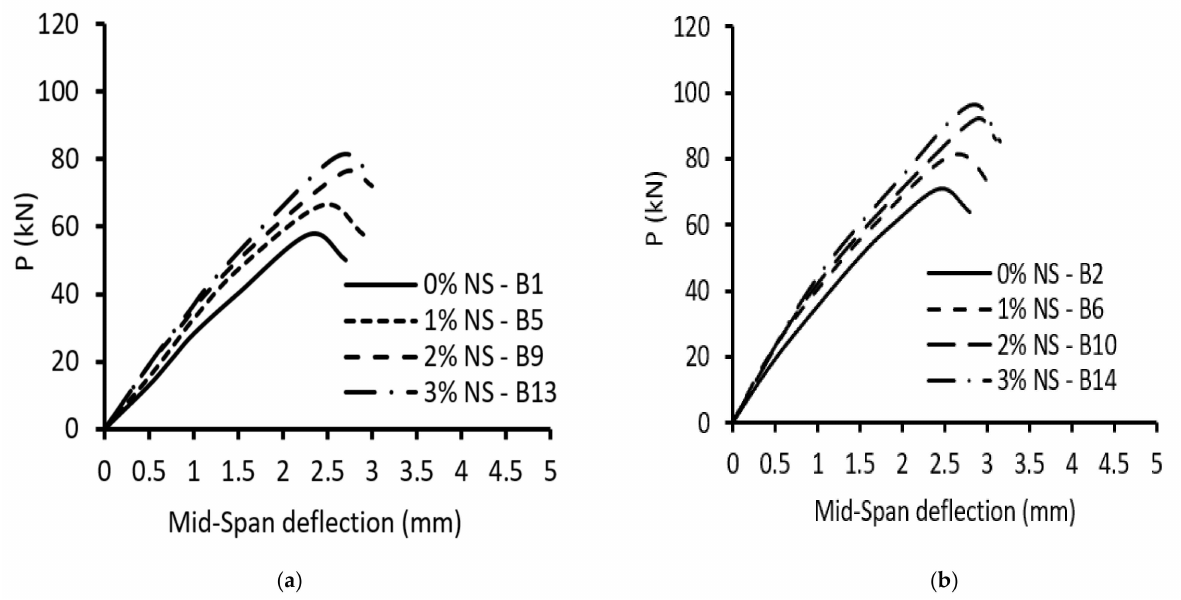
Figure 6. Load–deflection curves of beams with an (a/d) = 1.5: ( a ) without stirrups, ρ v % = 0%; ( b ) with stirrups, ρ v % =